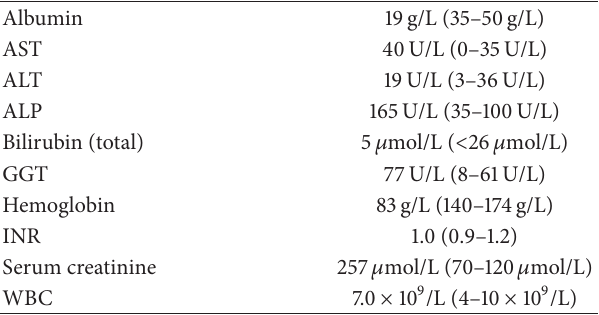
Table 1: Liver biochemistry prior to initiating HCV